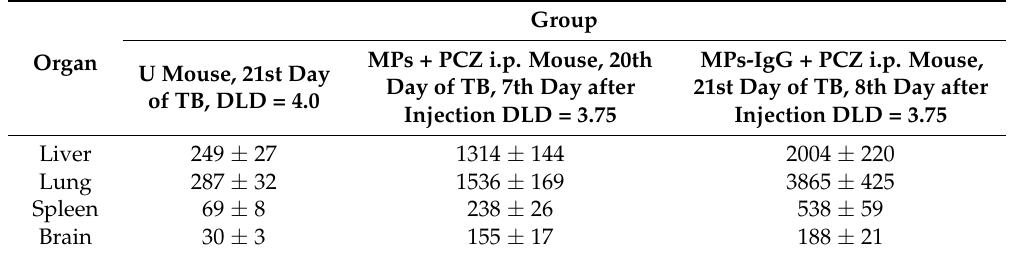
Figure 7. The results of phosphorescent platinum coproporphyrin (PtCP) luminescence on the surface ( A ) and within the slice of the lung ( B ) of mice on the seventh day after i.p. injection of particles (group MPs-IgG + PCZ i.p .) obtained with a sensitive laser fluorometric scanner diagram; ( C ) the comparison of tissue slices (after 50 days) luminescence of different organs: ( C1 ) lung, group MPs-IgG + PCZ i.p. ; ( C2 ) lung, group U ; ( C3 ) liver MPs-IgG + PCZ i.p. ; ( C4 ) brain. Table 3. Quantitative estimation of total organ slice luminescence (counts per standardized section